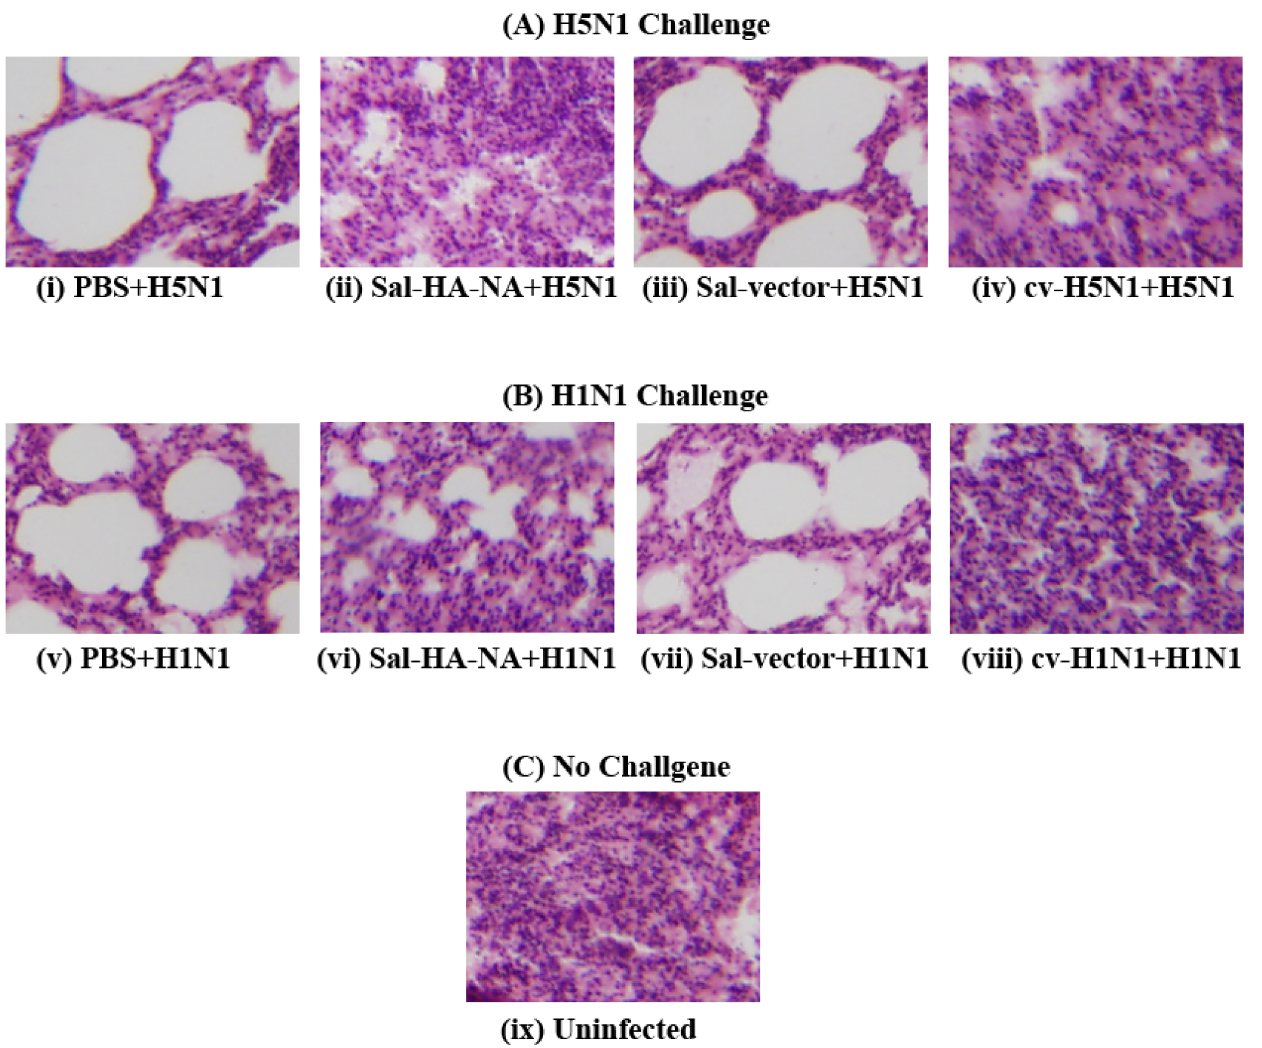
Fig 7. Photomicrographs of hematoxylin- and eosin-stained lung sections of mice at 7 days post-challenge. Mice were intragastrically immunized three times at day 0, 14, and 28 with PBS (i and v), the commercial H5N1 (cv-H5N1) (iv) and H1N1 vaccines (cv-H1N1) (viii), and Salmonella SL368 carrying the empty vector pVAX1 (Sal-vector) (iii and vii) and constructs p5HA and p5NA (Sal-HA-NA) (ii and vi), and then challenged intranasally with 20 LD 50 of lethal H5N1 (A/Viet Nam/1194R) and H1N1 (A/Puerto Rico/8/34) viruses at two weeks after final immunization. (A) mice challenged with H5N1 virus; (B) mice challenged with H1N1 virus; (C) uninfected mice with no virus